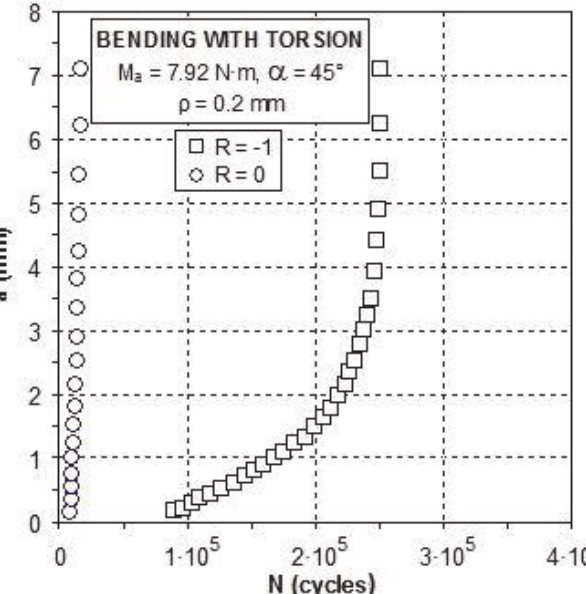
Figure 6: Fatigue crack length „a” versus number of cycles N (active side